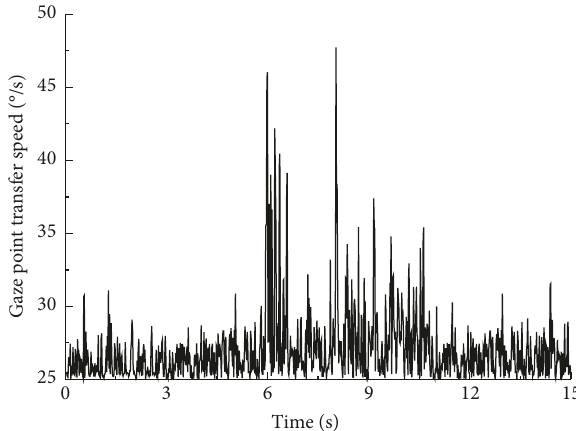
Figure 4: Speed of the shift of the point of gaze during the change of